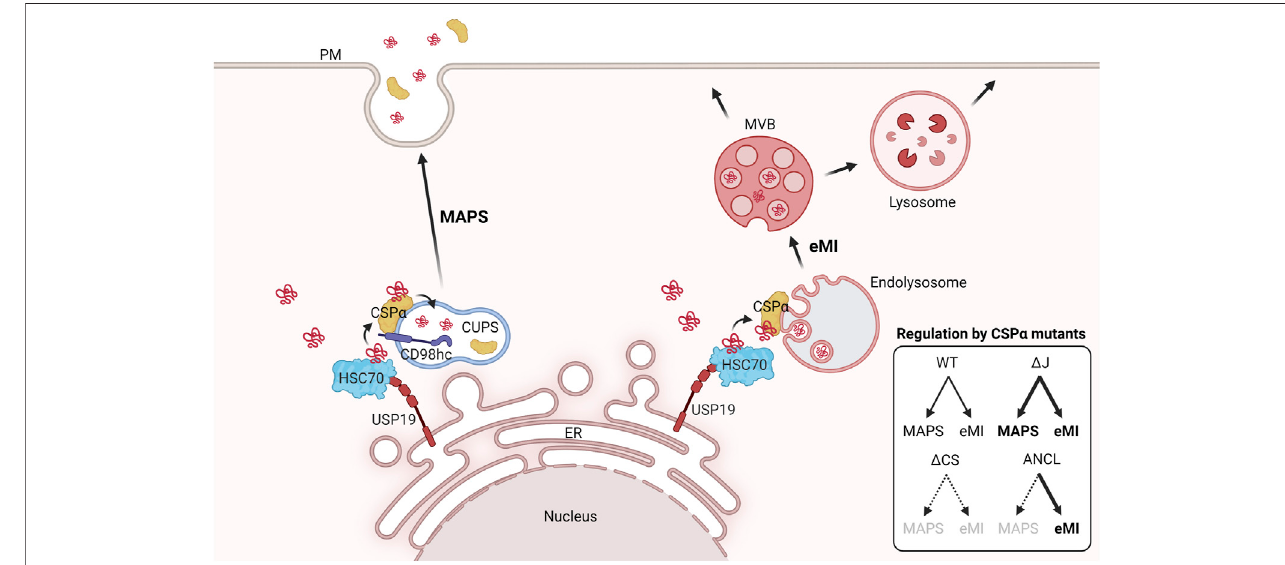
FIGURE 2 | CSP α couples MAPS to eMI to promote lysosome homeostasis. In mammalian cells, CSP α triages cytosolic misfolded proteins by two different mechanisms: misfolding-associated protein secretion and eMI-mediated degradation. In both cases, an ER-associated deubiquitinase USP19 recruits and deubiquitinates misfolded substrates at the ER. For MAPS, CSP α and HSC70 guide the cargos to a peri-nuclear secretory compartment for unconventional protein secretion (CUPS). CD98hc is required for targeting of CSP α /substrate complexes to this compartment. After CSP α chaperones substrates to the lumen of CUPS, the encapsulated MAPS cargos and CSP α are secreted possibly by vesicular traf fi cking between the CUPS and plasma membrane (PM). For eMI, CSP α also escorts misfolded proteins into endolysosomes by an ESCRT-dependent mechanism. The resulting multivesicular bodies containing misfolded cargos can be degraded or secreted after the fusion of MVBs with lysosomes or plasma membrane. The box indicates how these two processes can be differentially regulated by different CSP α mutant proteins. The fi gure was created by BioRender.